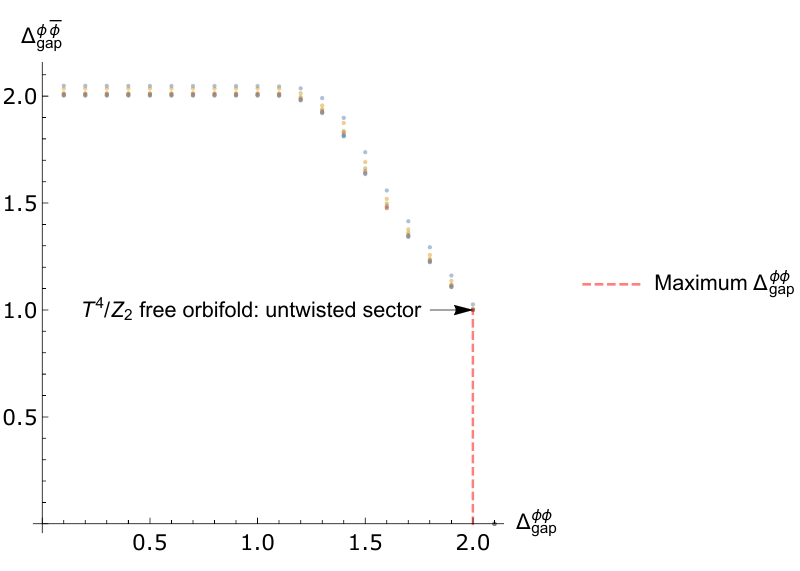
; b (cid:1) (cid:30) (cid:22) (cid:30) ) on the gap in the respective OPEs, gap gap is bounded above by 2, beyond gap